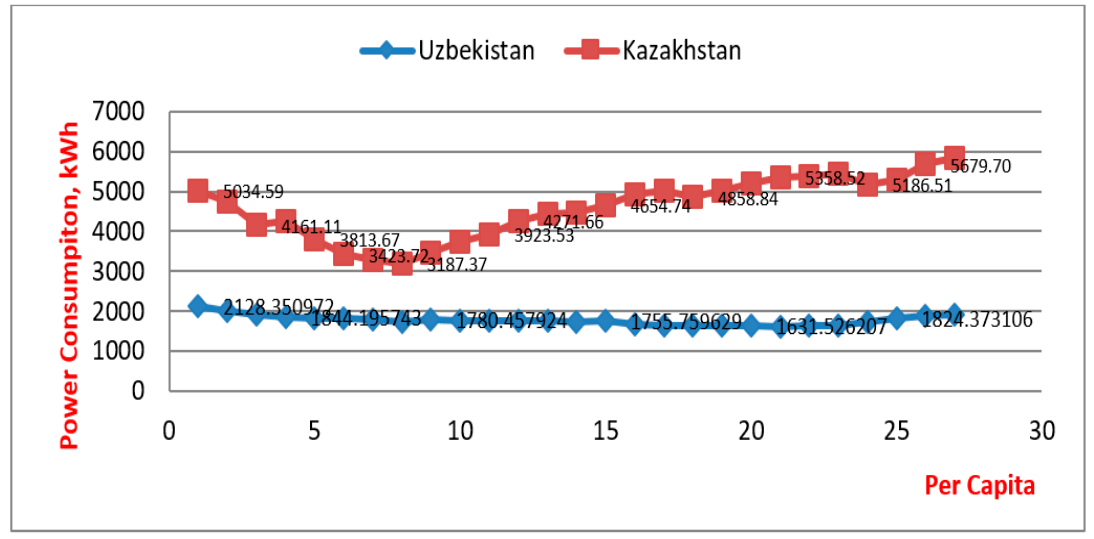
Figure 2. Electric power consumption (kWh per capita).